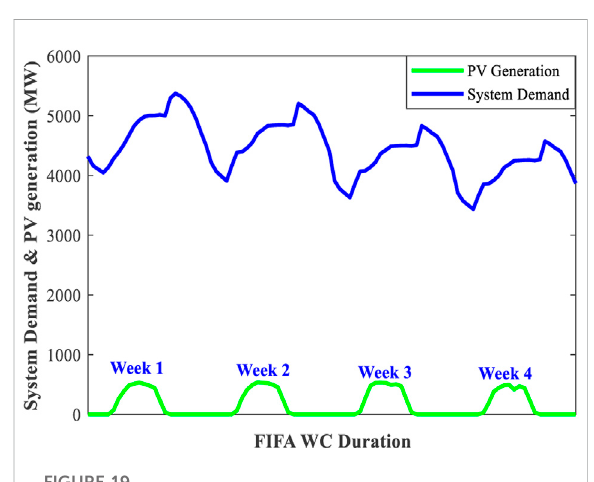
FIGURE 19 System demand and PV generation during the FIFA WC.